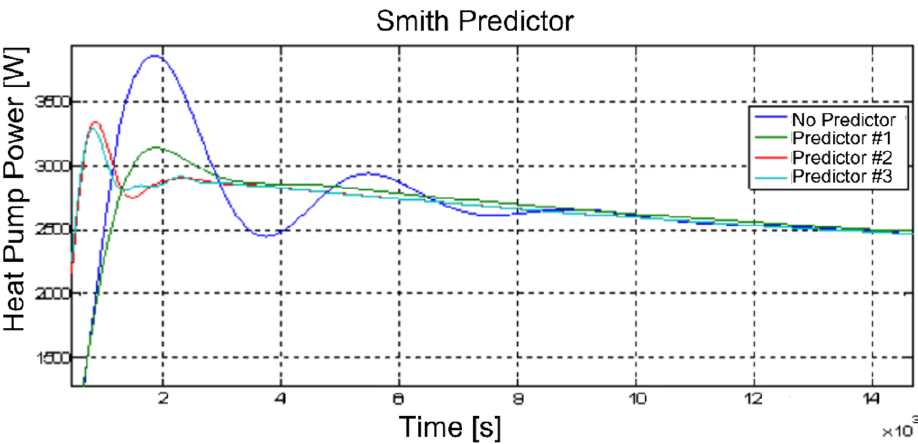
Figure 21. Control results: Smith predictor architecture performances (MV).